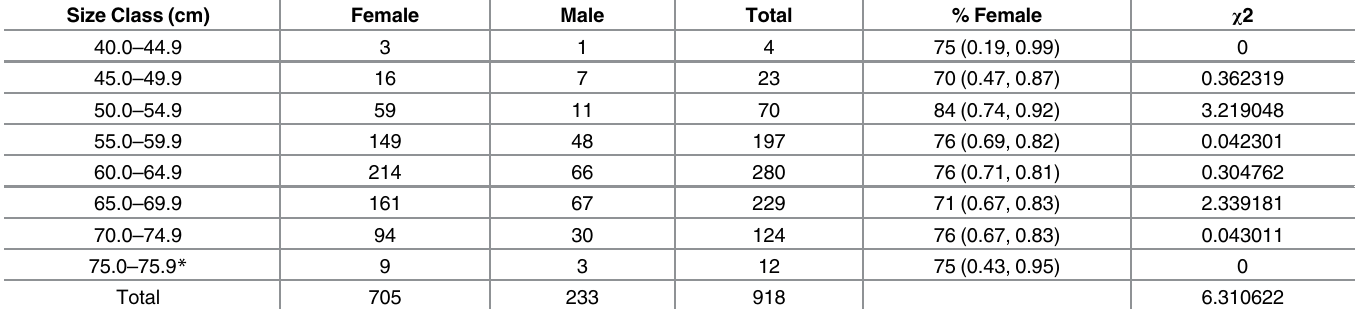
Table 2. Number of females, males, percentage females (95% confidence intervals) and χ 2 values across size classes (straight carapace length) for juvenile loggerheads ( Caretta caretta ). Size Class